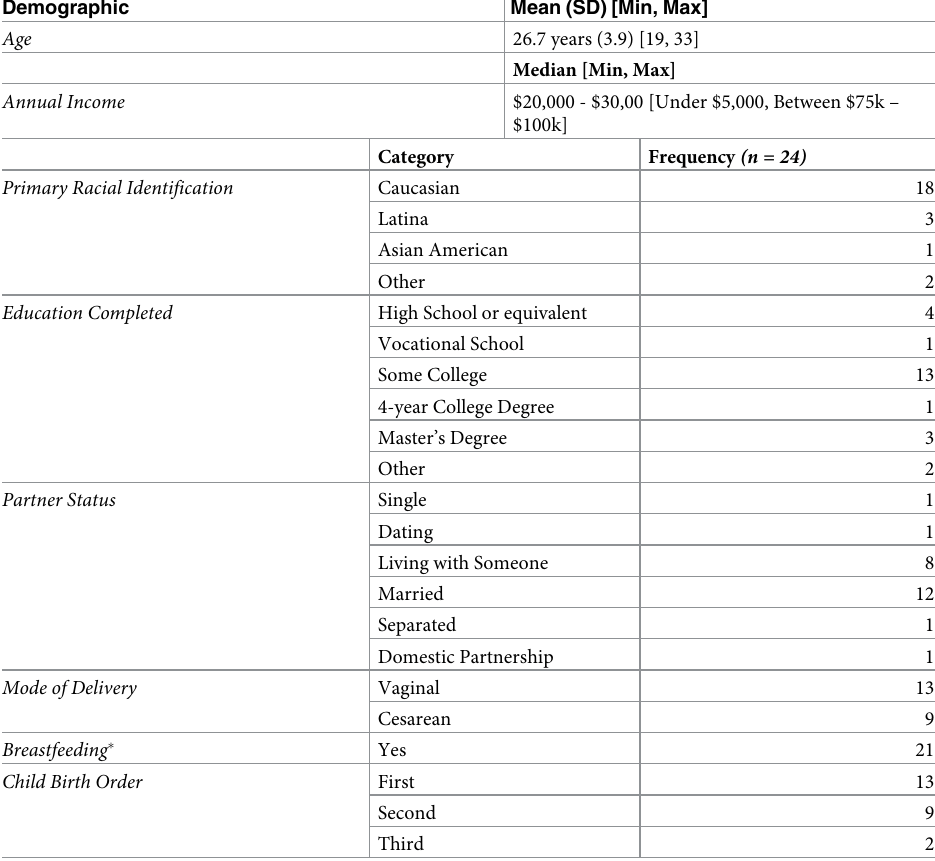
Table 1. Demographic information for mothers included in final